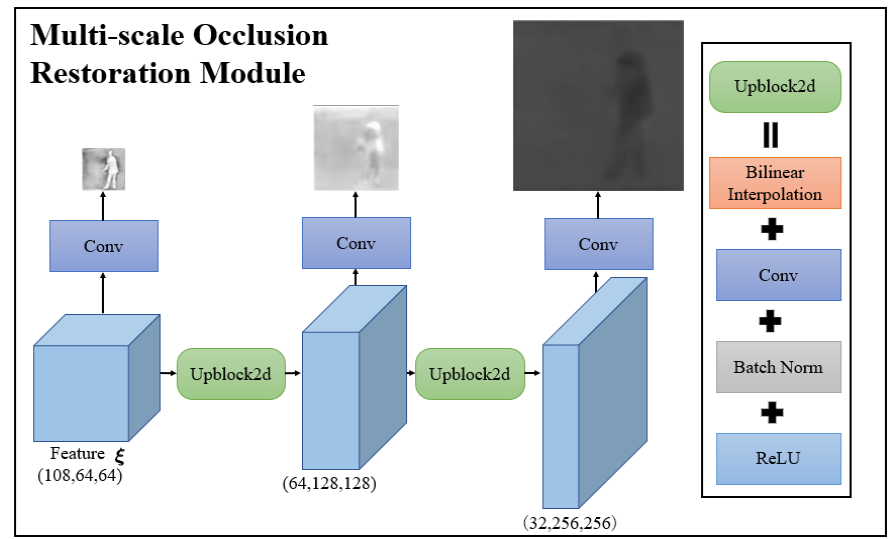
Figure 8. Diagram of the multi-scale occlusion restoration module.